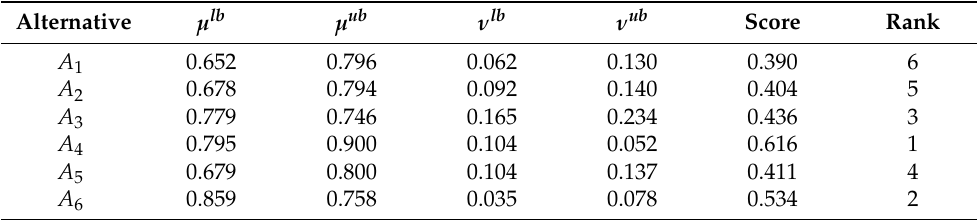
Table 7. Evaluation scores and ranks for COVID-19